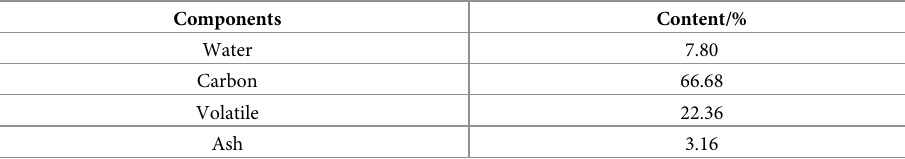
Table 2. Industrial analysis of coal sample.